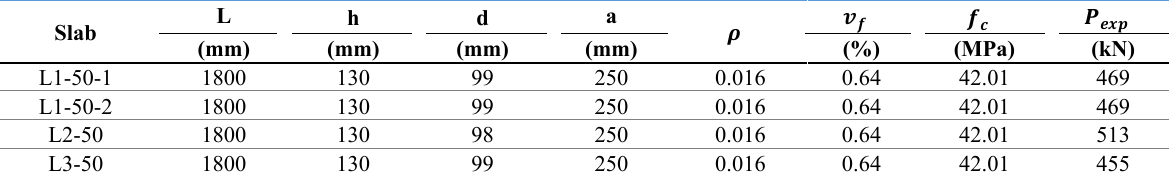
Table 6. Experimental tests properties from Alves et al. [25]. Slab